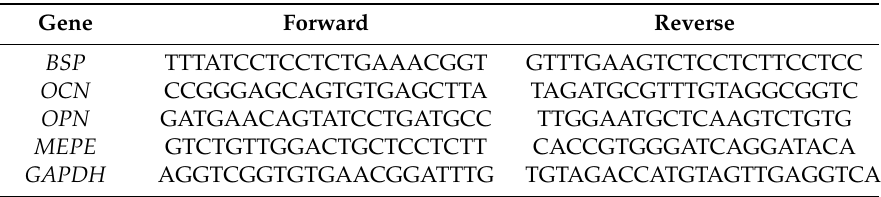
Table 2. Primer sequences used for quantitative real-time polymerase chain reaction. Gene Forward Reverse BSP